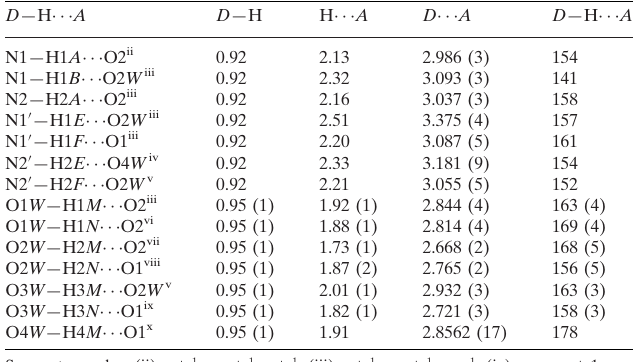
Hydrogen-bond geometry (A˚ , (cid:3)